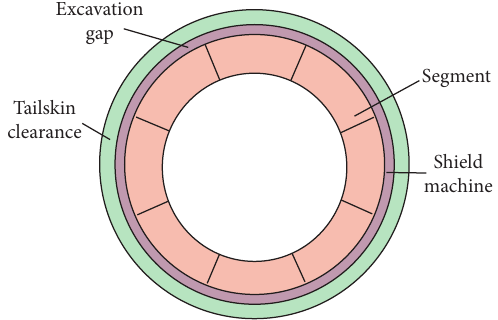
Figure 6: Numerical calculation of shield Table 1: Mechanical properties of EPB components.